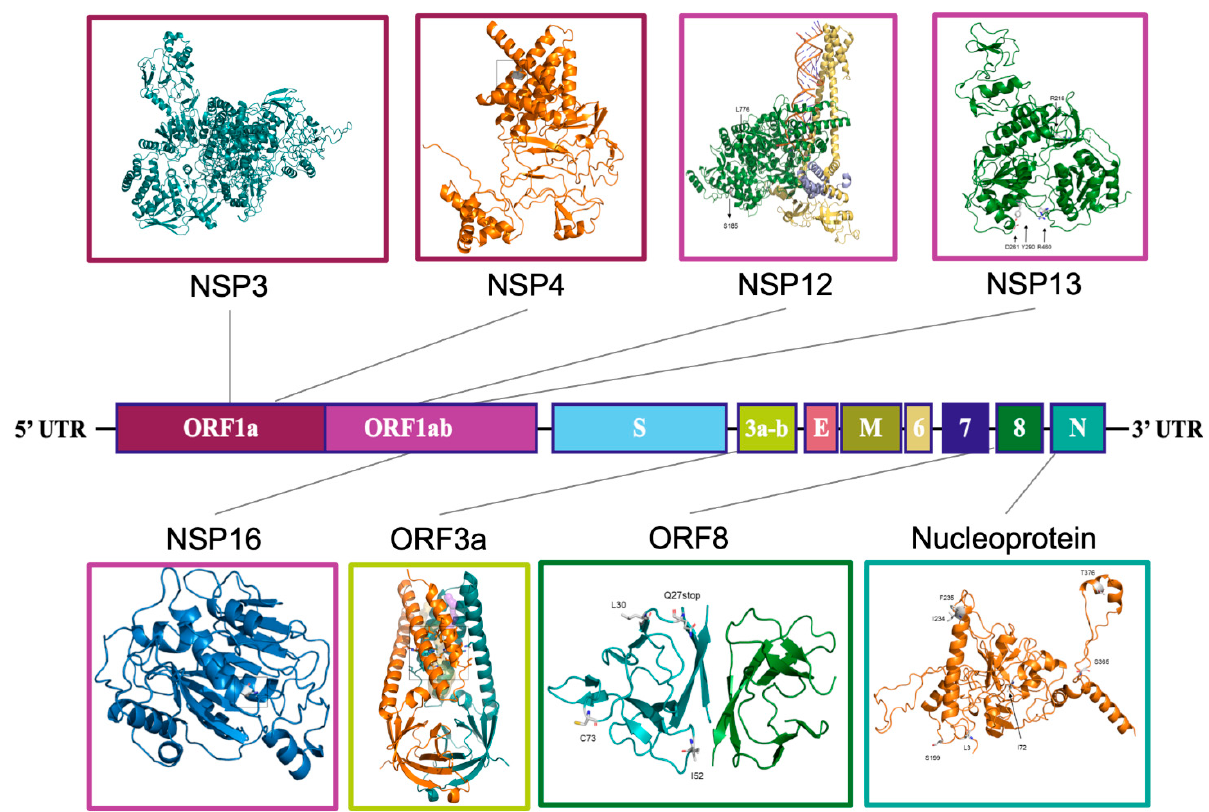
Figure 3. Genome layout of genes/proteins carrying mutations emerged during the year 2020. The approximate positions on the SARS-CoV-2 genome of genes coding for proteins carrying mutations from the year 2020 were subjected to structural analysis. The protein structures are displayed as ribbon models and enclosed in frames colored as the corresponding ORFs. Table 3. Impact of mutations on protein conformation and stability.